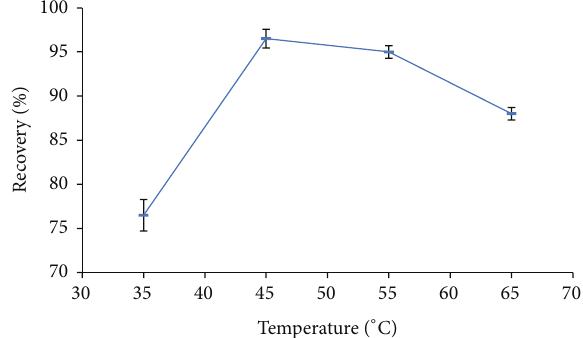
Figure 2: Effect of various extraction temperatures on AFM1 recovery (mean ± SD, 𝑛 = 2